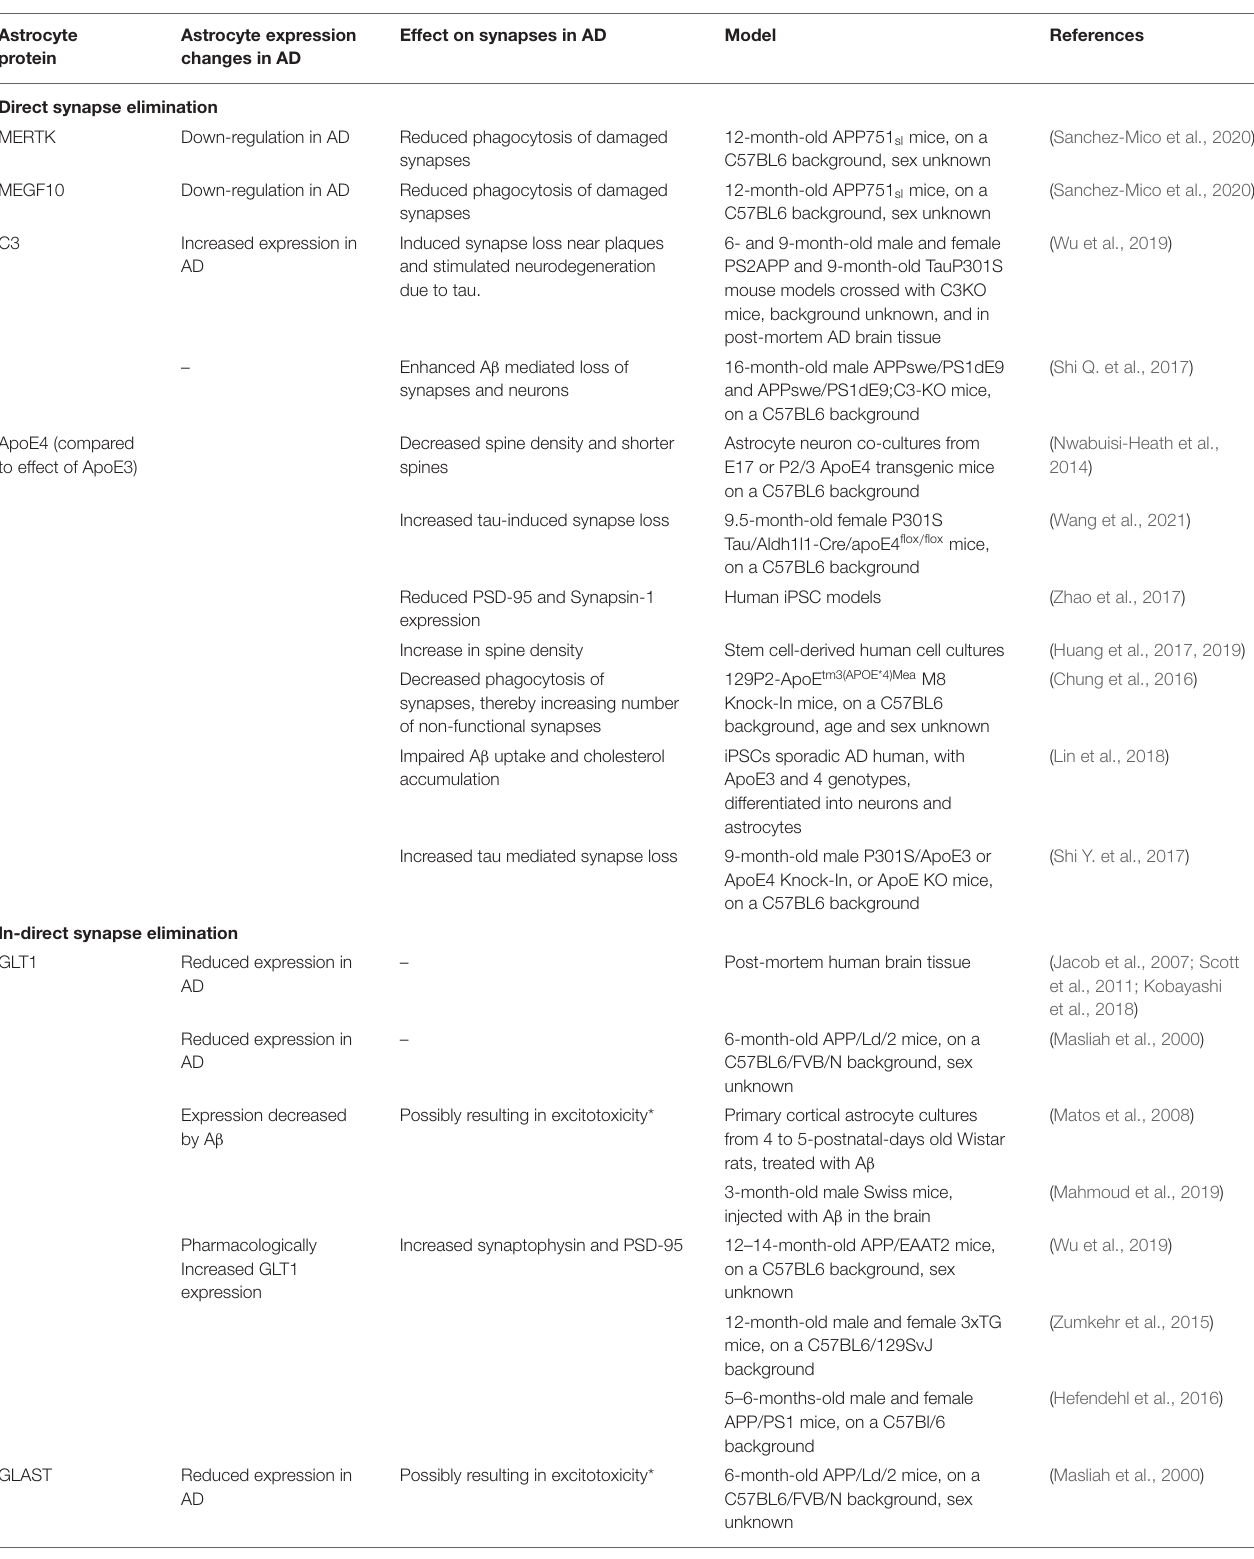
TABLE 1 | Astrocyte proteins involved in direct and indirect synapse